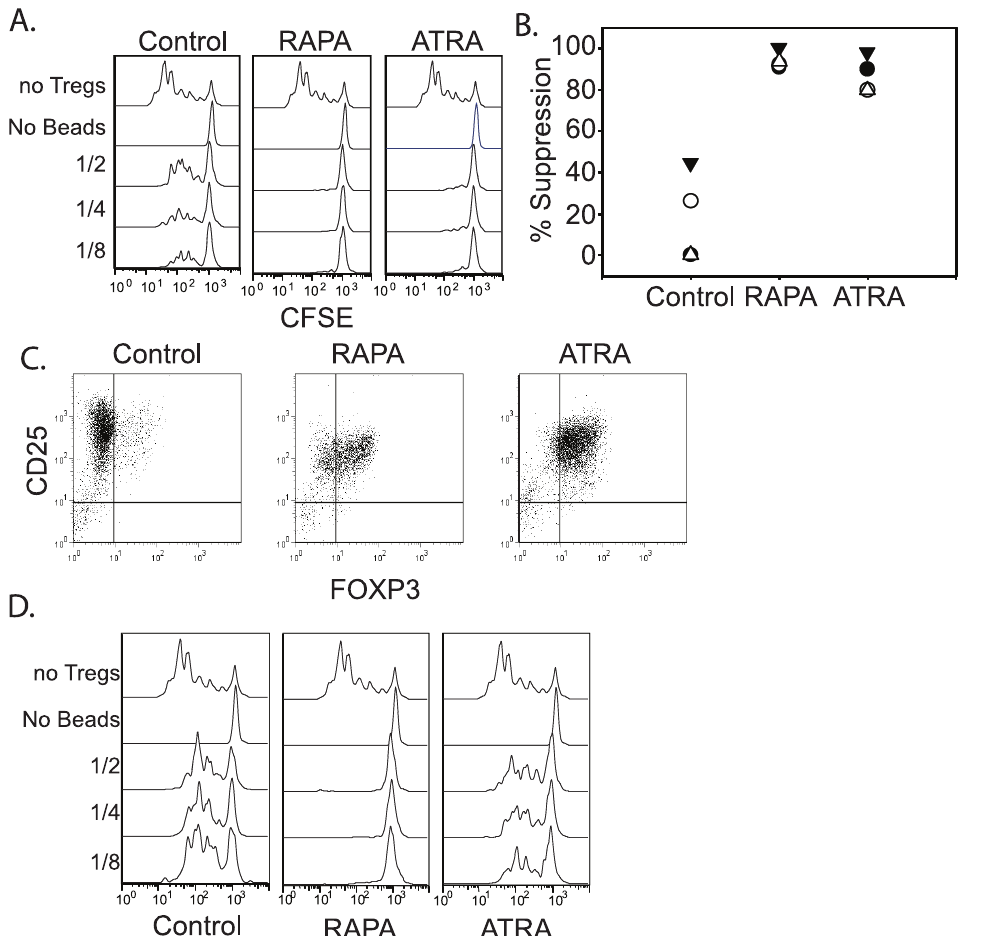
Figure 2. Tregs undergoing more than one round of ex vivo expansion in the presence of ATRA do not maintain their suppressive activity. A . Highly enriched Tregs expanded for 12–15 days under control conditions, or in the presence of ATRA or RAPA as described in Fig 1, were tested in a suppression assay. Autologous PBMCs were labeled with CFSE, stimulated using anti-CD3 Ab coated beads, and mixed with either no Tregs (top panel) or expanded Tregs at Treg:PBMC ratios of 1:2, 1:4 or 1:8. Histograms show the expansion of CD8 + T cells. PBMCs that did not receive anti-CD3 Ab coated beads were used a negative control. B . Suppressive activity of cultured Tregs from 4 different donors was calculated as described in the Method and Materials Section. Depicted are the % suppression values obtained from the 1:4 Treg:Eff cultures. C . and D . After a single round of expansion, Tregs were restimulated using anti-CD3 loaded K.64.86 cells and cultured under the same conditions as during the first stimulation. After an additional 12 days of culture, FOXP3 expression was analyzed by flow cytometry ( C .), and a suppressive assay was performed and analyzed as described above ( D .). FOXP3 data is representative of 3 donors, and the suppressive assay data is representative of 2 of 3 cultures. One donor maintained suppressive activity in the presence of ATRA treatment (data not